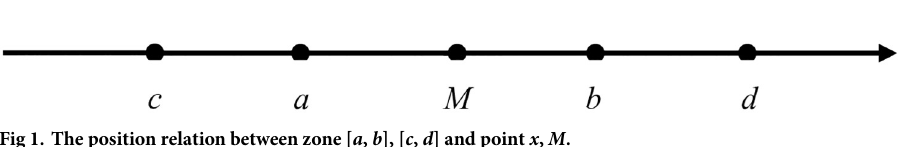
Fig 1. The position relation between zone [ a , b ], [ c , d ] and point x , M